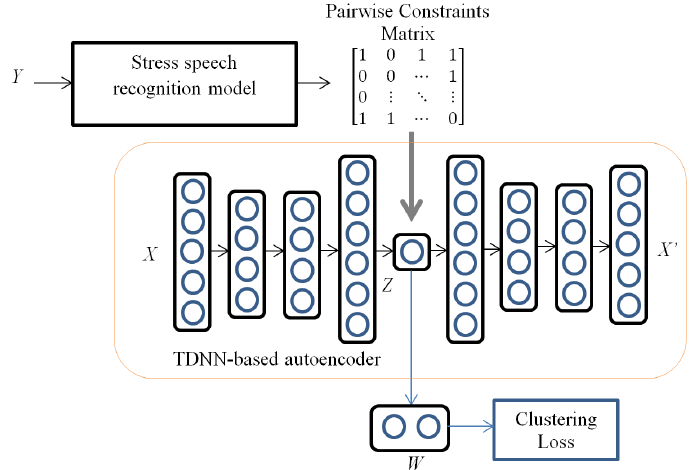
Figure 1. The Proposed SDETC’s